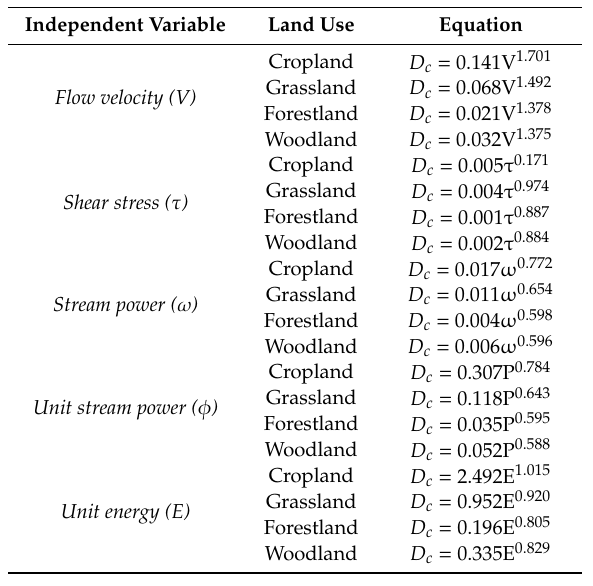
Table 5. The equations correlating the rill detachment capacity ( D c , [kg m − 2 s − 1 ) with the hydraulic parameters (flow velocity, V [m s − 1 ]), shear stress, τ [Pa], stream power, ω [kg s − 3 ], unit stream power, P [m s − 1 ], and unit energy, E [cm]) for four land uses of the Saravan watershed (Northern Iran) ( n = 25).